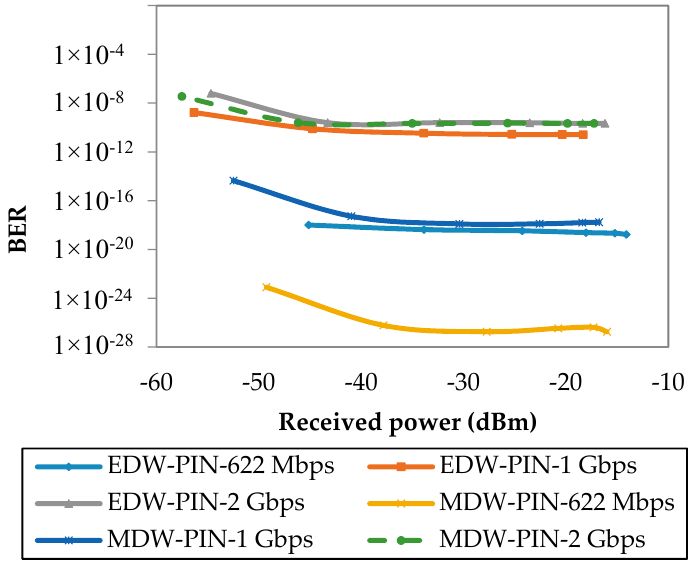
Figure 10. BER versus received power for the SAC-OCDMA system using different codes and SPD detection technique at different bit rates in the presence of both DCF and EDFA.